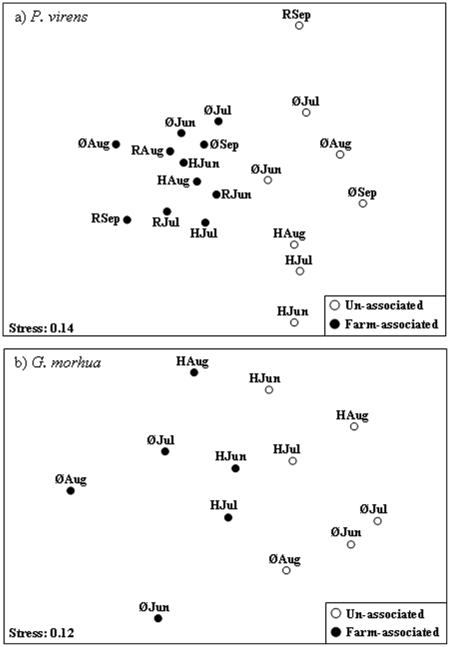
Non-metric multi-dimensional scaling plots of dietary items of saithe Pollachius virens and Atlantic cod Gadus morhua sampled from farm and non-farm locations throughout Norway from June to September.a: saithe; b: Atlantic cod. Each point is based on mean weights of prey categories for the specific month. Jun = June; Jul = July; Aug = August; Sep = September. R = Ryfylke; H = Hitra; Ø = Øksfjord.